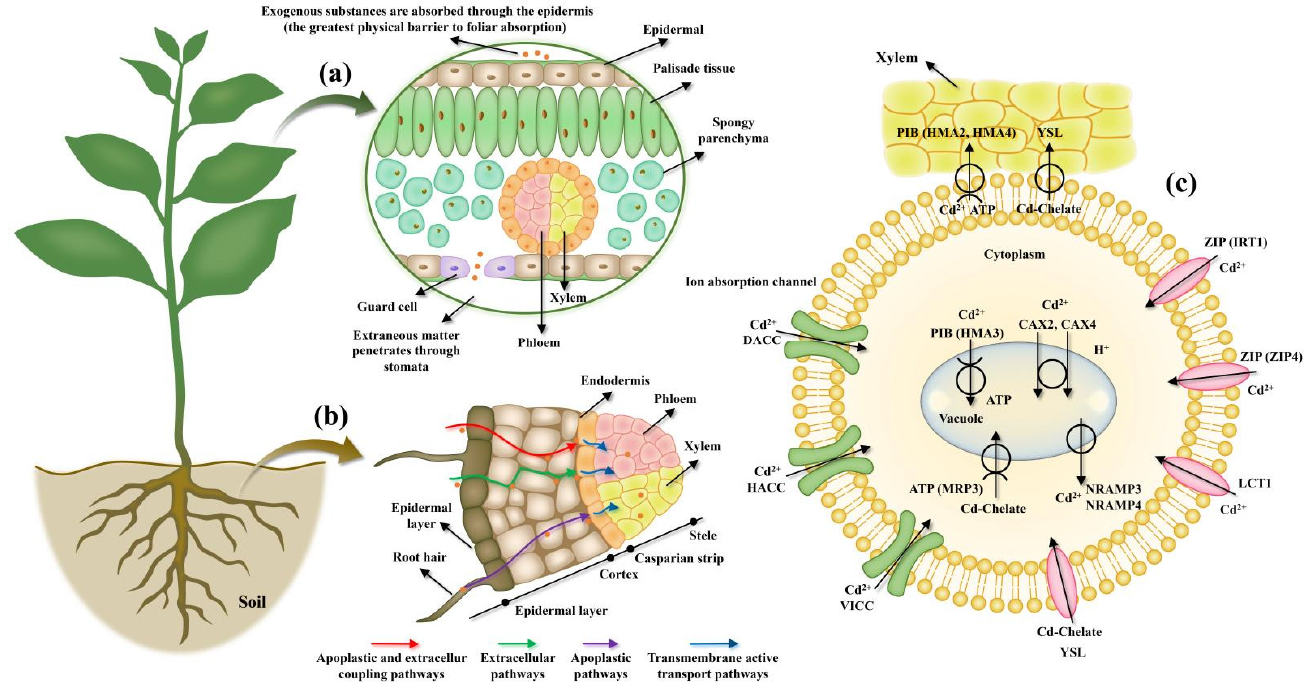
Figure 2. Absorption and transport of HMs by leaves and roots. ( a ) The absorption process of HMs by plant leaves. ( b ) The transport process of HMs absorbed by plant roots to the aboveground issues. ( c ) Specific proteins that control Cd’s ability to enter the root symplast, Cd’s isolation in vacuoles and its transport to the xylem [50]. DACC: depolarization-activated calcium channels; HACC: hyperpolarization-activated calcium channels; VICC: voltage-insensitive cation channels.